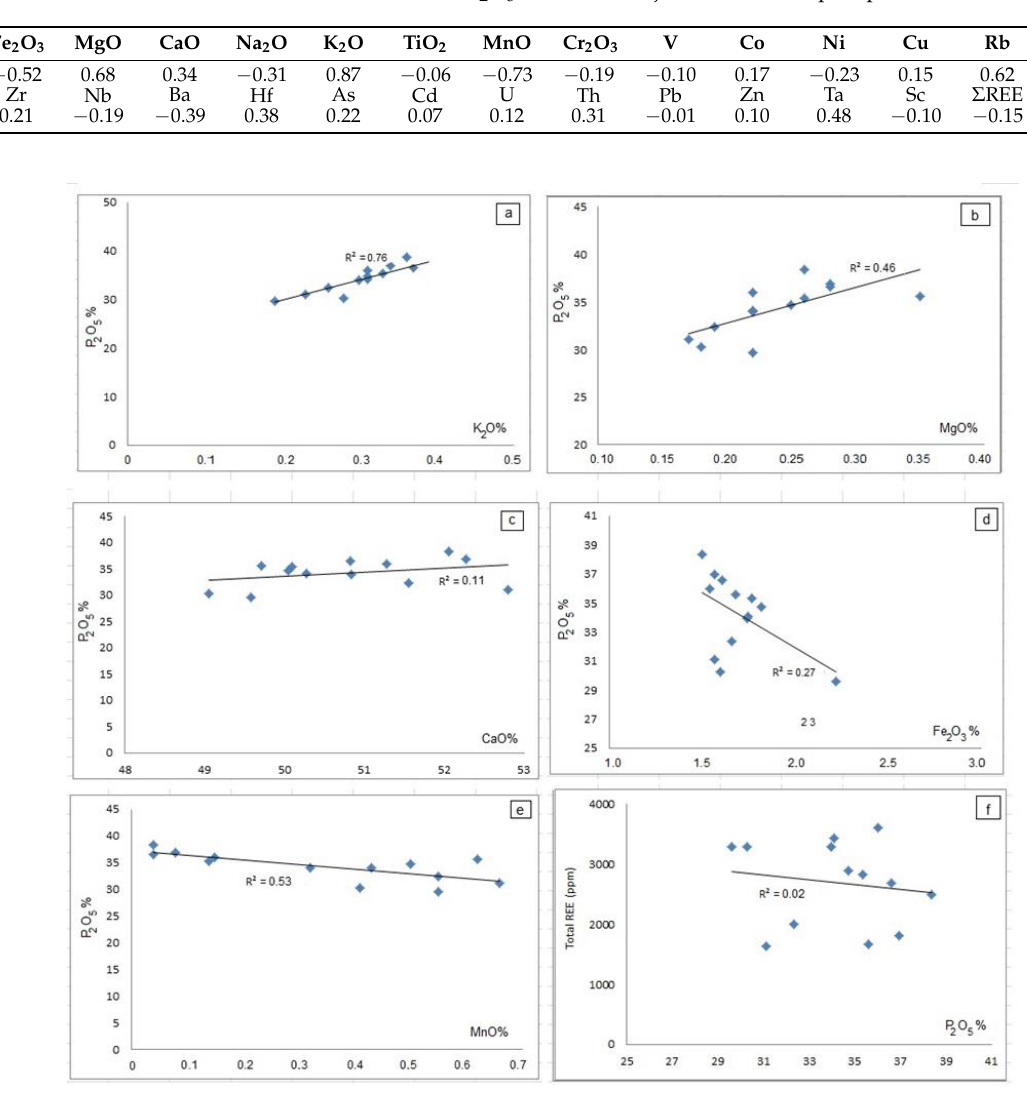
Table 2. Correlation coefficients between P 2 O 5 and other major oxides in the phosphate nodules.